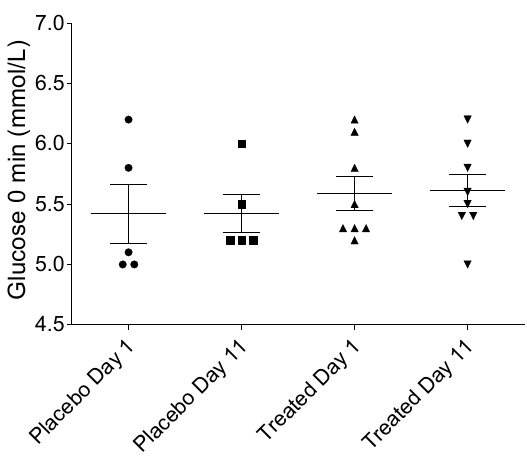
Figure 1. Fasting serum glucose levels in the placebo- and fenugreek-treated subjects. No significant differences were found among groups.